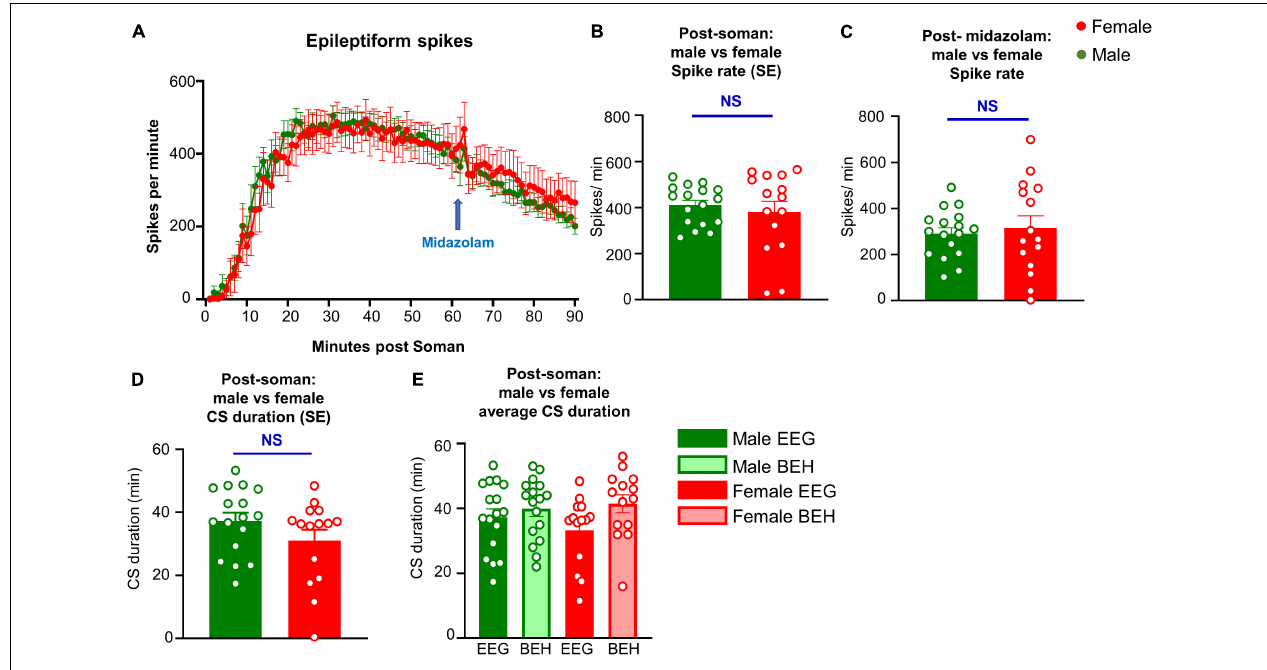
FIGURE 4 | Seizures (CS, convulsive seizure) detected on EEG and spike rate comparison between male and female rats during SE, and the immediate effect of midazolam (3 mg/kg, i.m.) on spike rate. (A) Spike rate over time between male and female animals. (B,C) Average spike rate during soman (B) and in the first 30 min after soman. (D) Total duration of seizures post soman. (E) SE duration comparison between behavioral (BEH) SE and EEG based SE in males and